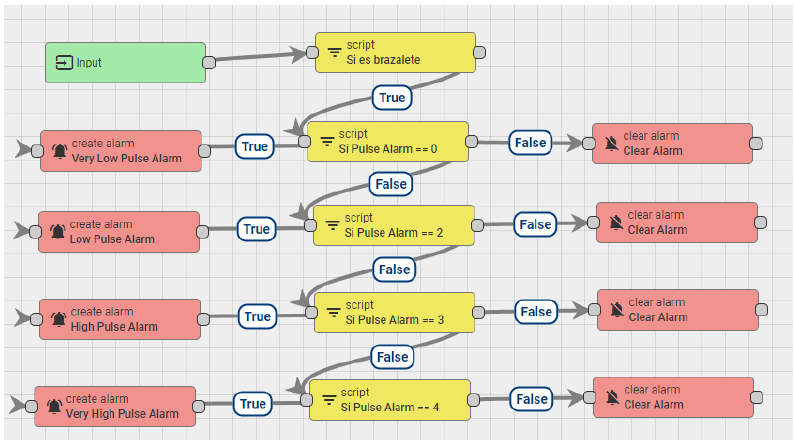
Figure 8. Bracelet pulse alarm